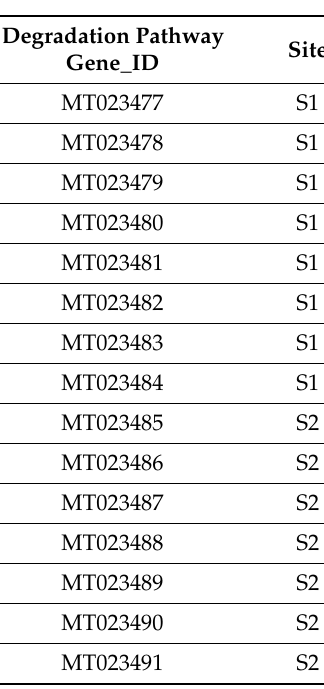
Table 5. Annotation of genes and microorganisms involved in tolerance to Cd and Pd predicted by HMM profiles using the cobalt-zinc-cadmium resistance protein CzcA and the 2-isopropylmalate synthase for Cd, and the P-type Cu2 + transporter, P-type Cu + transporter and Zn2 +/ Cd2 + -exporting ATPase for